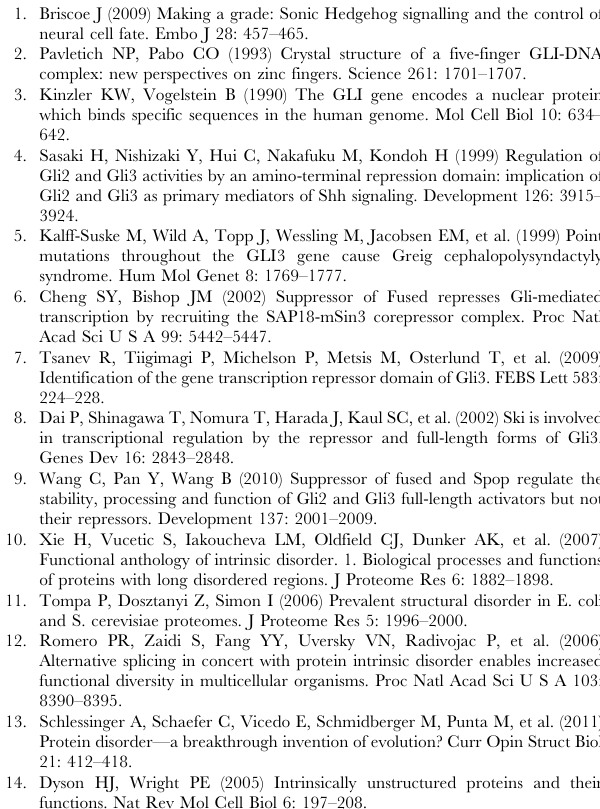
Figure S1 The UV chromatogram of the sample Gli3RD, 280 nm. The peak RT 16,52 min was identified as protein with MW 15570.9 Da on the basis of the ESI-MS spectrum deconvulated with the MagTrans software. (TIF) Figure S2 The ESI-MS spectrum of Gli3RD. (PDF) Figure S3 Overlaid chromatograms of the sample Gli3RD. Black - UV 280 nm, red - TIC m/z 300 – 2000 Da. (TIF) Figure S4 The SDS-PAGE of Gli3RD. The gel was made to 12% acrylamide, bis-acrylamide 29:1. (JPG) Methods S1 HPLC purification.